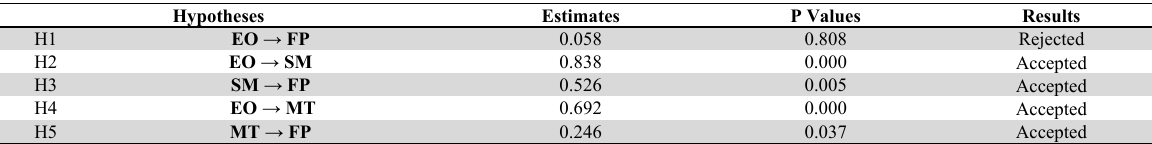
Path estimated results